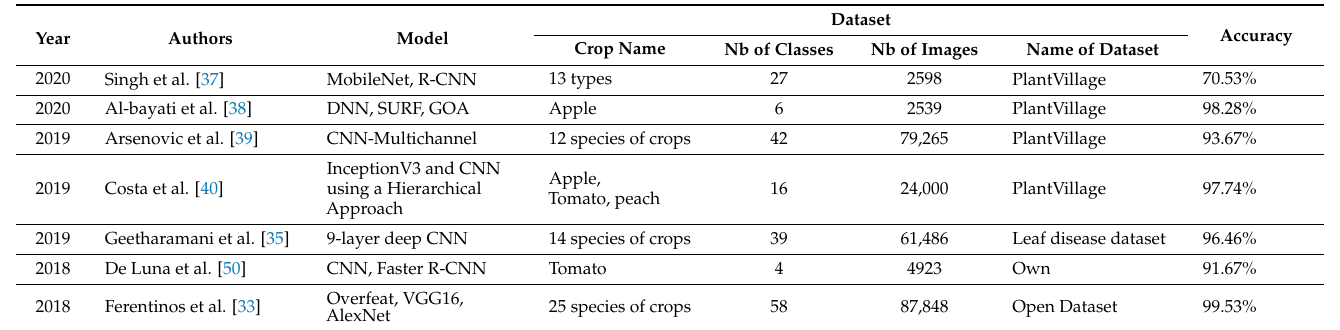
Table 2. A brief summary of different research on transfer and deep learning since 2018 for identifying crop